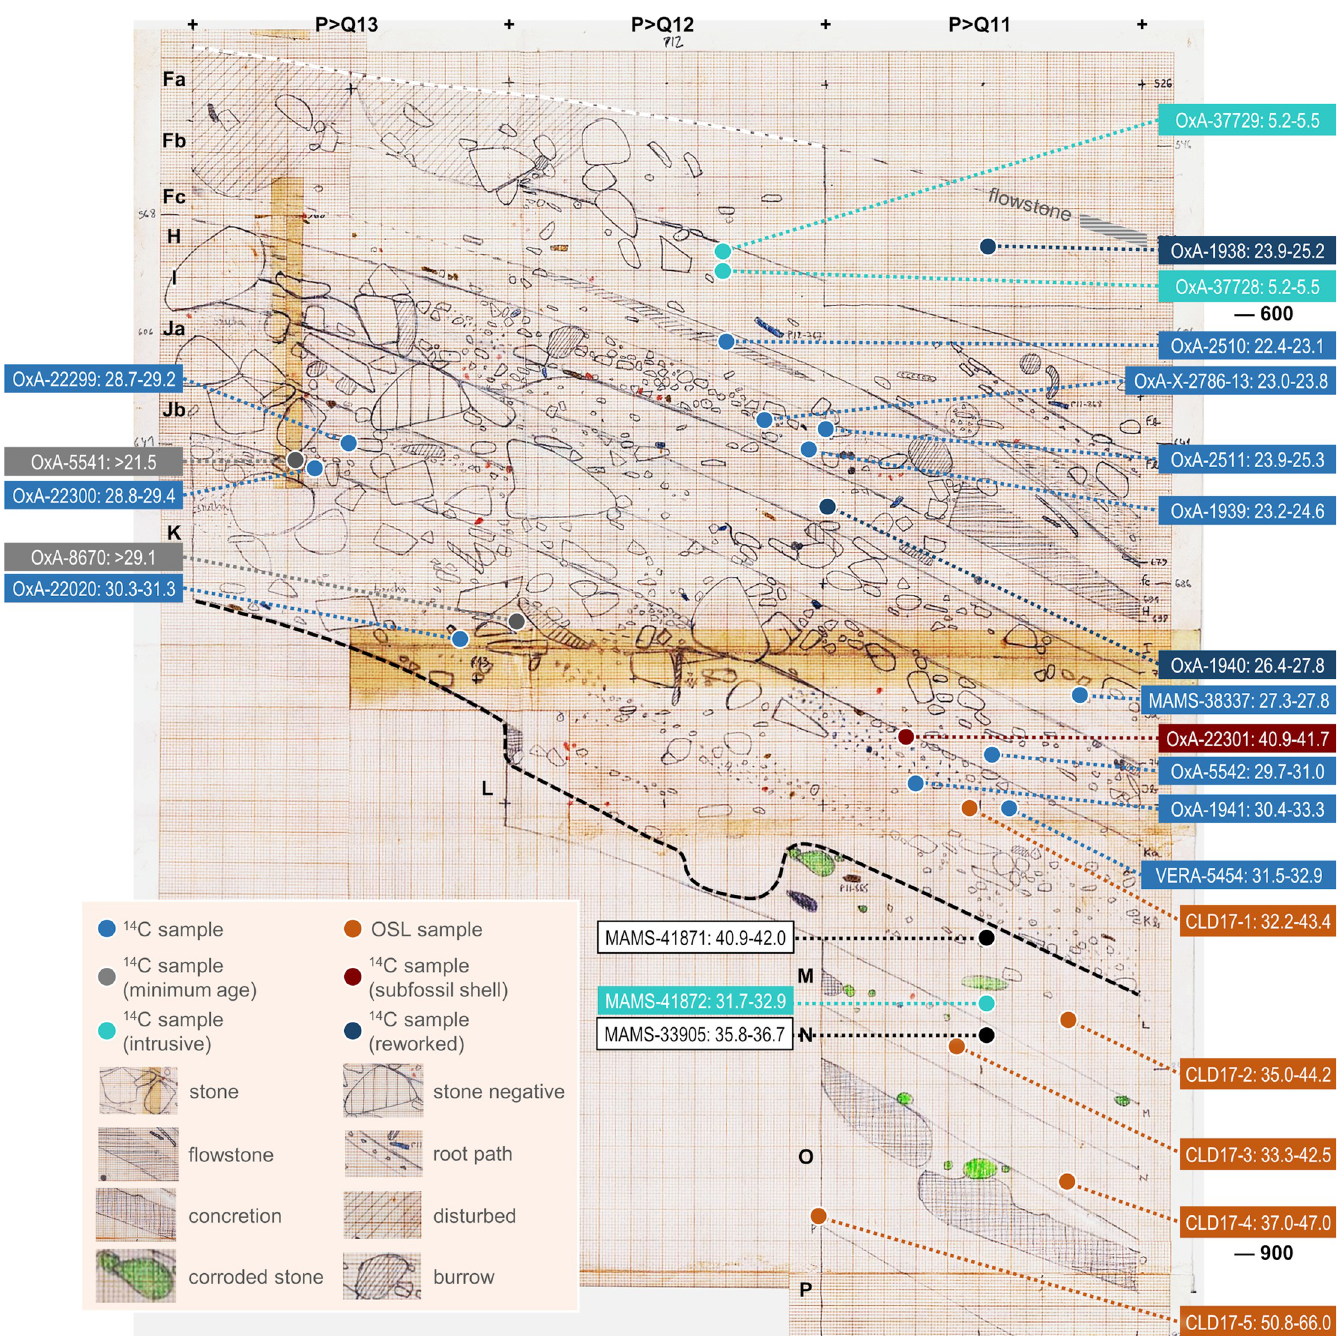
Fig 15. Stratigraphic provenance and significance of the back chamber’s pleistocene dating samples. OSL samples were taken from the P > Q13-11 profile at the indicated positions (except for the layer O sample, which was taken from the P11 > 12 profile at x = 30 and is herein represented as a projection). All twenty-five single- item, AMS-dated radiocarbon samples are projected using their y- and z-axis coordinates (five non-plotted items are assigned to the centroid of their square/spit provenience). The colour codes reflect the significance attached to radiocarbon results in terms of accuracy and site formation process (MAMS-33905 and MAMS- 41871 are not coded because their interpretation remains open). The lab numbers are associated with the 95.4% probability intervals of the samples’ calendar ages. The original field record was hand-drawn at 1:10. Elevations are in cm below datum.